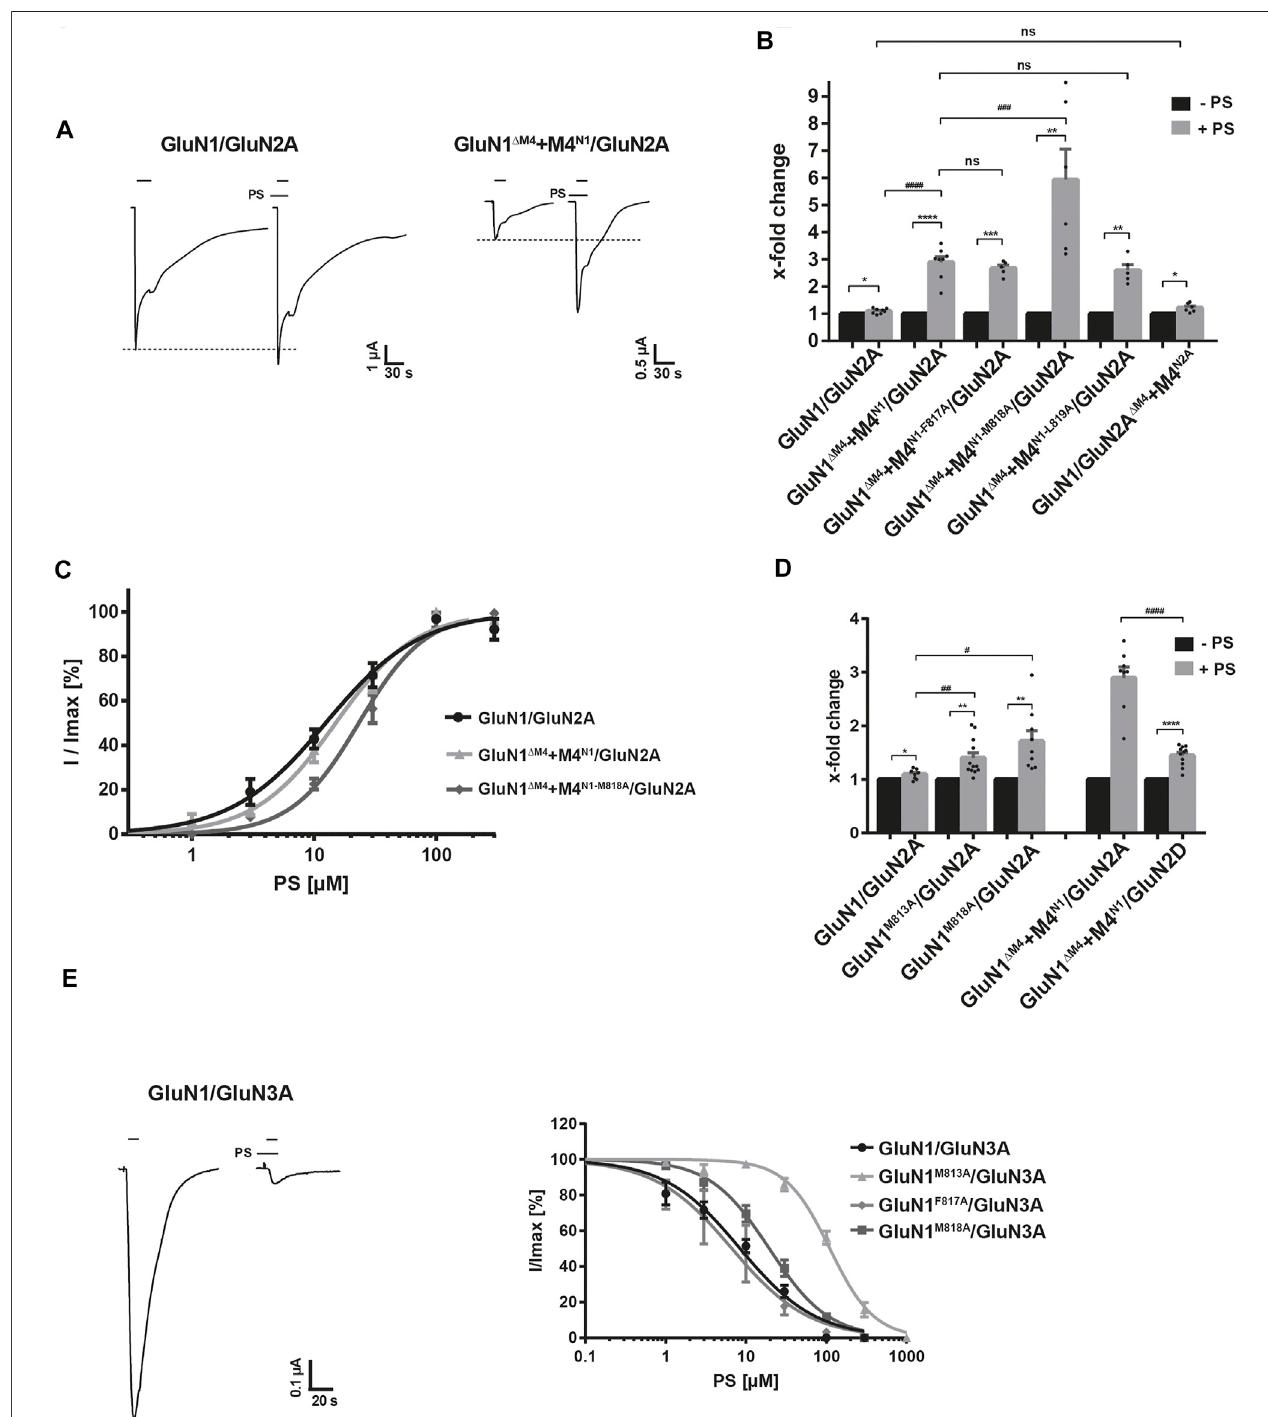
FIGURE 4 | Identi fi cation of a NAM recognition site of pregnenolone sulfate at GluN1-M4. (A) Representative TEVC images of I max potentiation of PS at GluN1/ GluN2AandGluN1 Δ M4 +M4 N1 /GluN2AreceptorsshowingastrongincreaseinpotentiatingeffectforM4segmentco-expression. (B) Quanti fi cationofI max potentiationof PS at GluN1/GluN2A, GluN1 Δ M4 +M4 N1 /GluN2A, M4 segment mutants F817A, M818A, and L819A, and GluN1/GluN2A Δ M4 +M4 N2A . Coexpression of M4 N1-F817A and M4 N1-L819A showed no effect on the potentiating effect compared with unmutated M4 N1 . Co-expression of M4 N1-M818A showed a strong increase in I max potentiationcomparedtoGluN1 Δ M4 +M4 N1 /GluN2A[t(12) (cid:1) 3.08; p (cid:1) 0.0095],indicatinganimpairedNAMrecognitionsite.GluN1/GluN2A Δ M4 +M4 N2A wasnotdifferent from the wt full-length receptor. Statistical analysis was performed using paired t-tests between I max [-PS] and I max [+PS] (*). Potentiation of the different mutants was